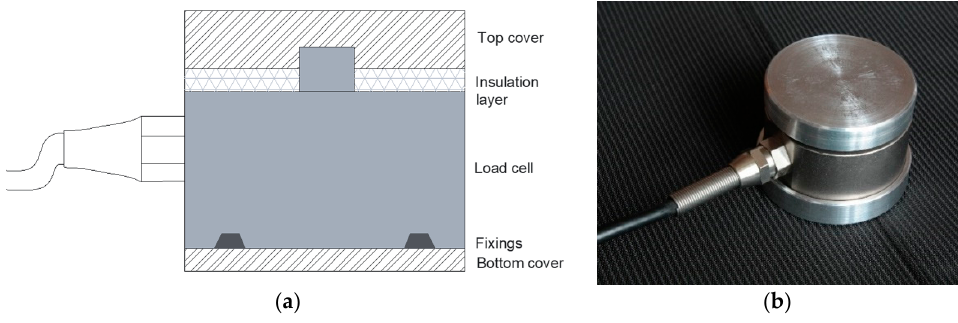
Figure 5. Load cell sensor, cased: ( a ) schematic representation, ( b ) final assembly.